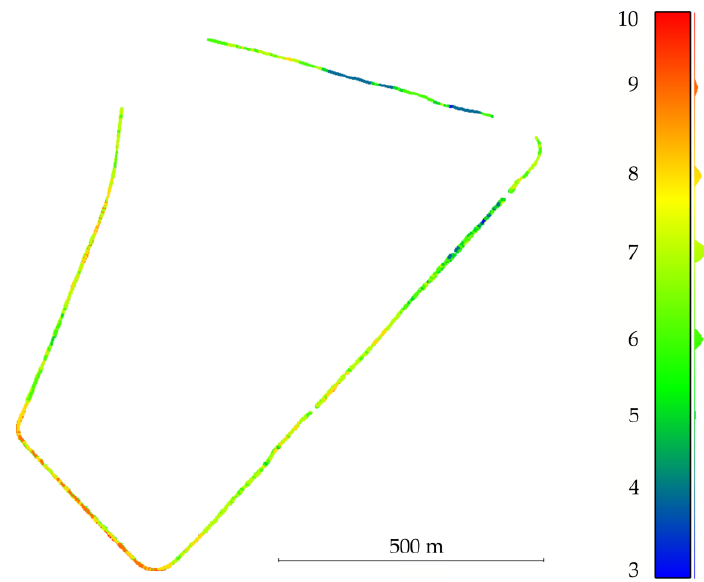
Figure 17. The number of available satellites observed by the satellite compass on the test route.